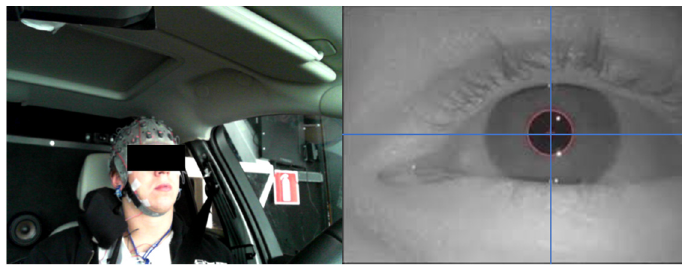
Figure 2. A test participant and his detected eye-pupil position.